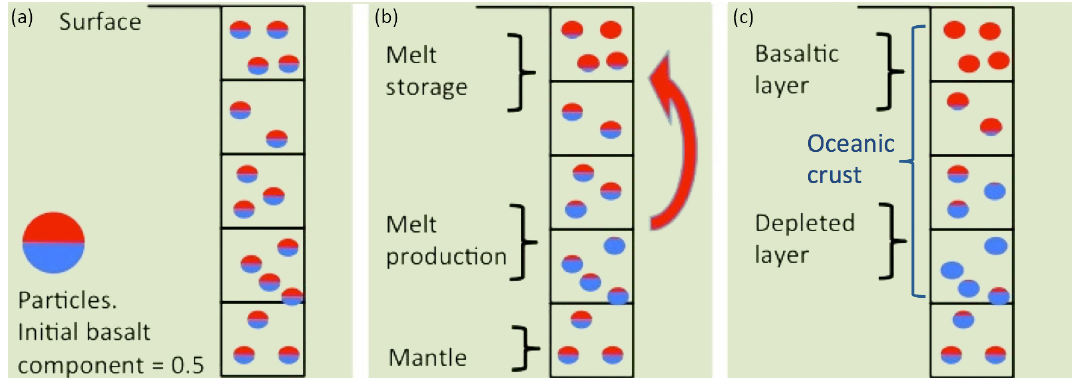
Figure 1. Schematic illustration of the use of particles in the transport of bulk composition on melting. Five grid elements just below the surface are schematically drawn (black squares), with the circles in them representing the particles. The basaltic component each particle is carrying is indicated by the red coloured area. A red particle is completely basaltic ( C = 1), whereas a blue particle is completely depleted ( C = 0). Note that only a few particles per grid element are drawn, while our model uses up to 35 particles per grid element. Time progresses from left to right, i.e. (a) to (c) . (a) Situation before melting. All particles indicated have a basaltic component of 0.5 (50%). (b) Movement of melt. The particles around the third grid element from the top start to produce melt. They thereby decrease their basaltic component (formation of residue) and send the produced basalt to particles closer to the surface (indicated by the red arrow). The particles closer to the surface increase their basaltic component as a result of receiving melt. (c) Result after some time. The particles at the layer closest to the surface received so much melt that they have become completely basaltic, and the second layer from the top start to become more basaltic as well. The area below, where melt has been produced, now forms a layer of depleted material. In this diagram the particles have not been moved. In the model the particles are advected by mantle